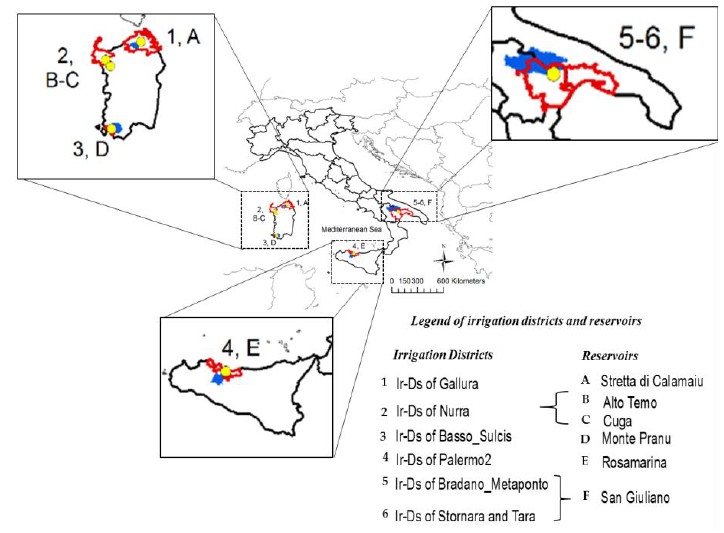
Figure 2. Reservoirs (yellow points), irrigation districts (red perimeters), and basins (blue areas) selected in the Mediterranean areas of Southern Italy.